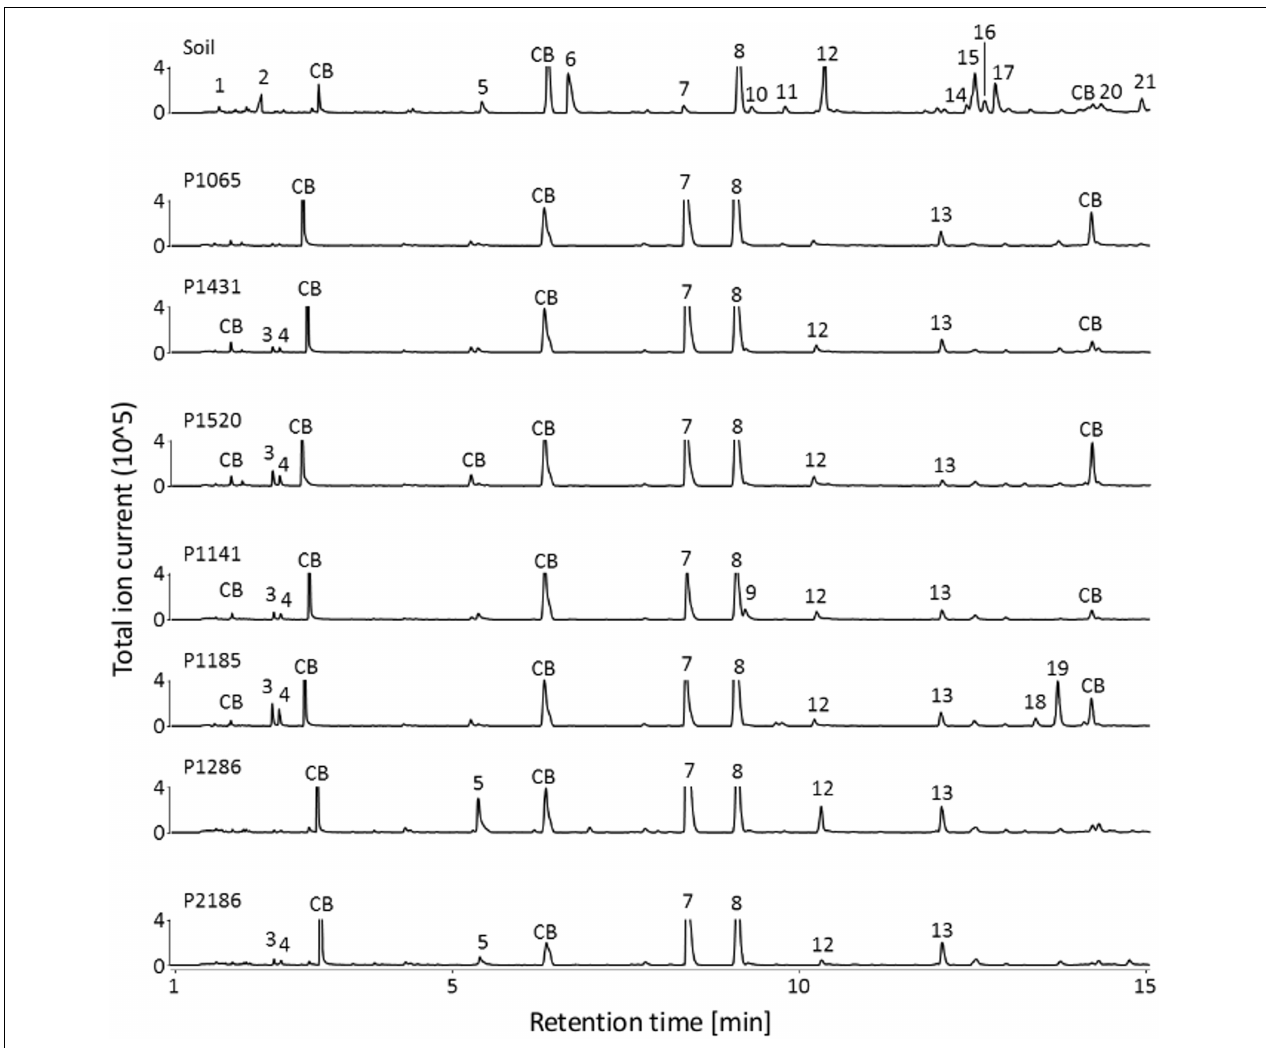
FIGURE 4 | VOCs detected in non-inoculated and Fusarium -inoculated soil samples. GC/MS chromatograms (TIC) illustrating the volatile profiles of non-inoculated soil samples and of Fusarium inoculated soil samples. Fusarium strains overall decreased the number of VOCs detected in the chromatograms compared to non-inoculated soil. CB: column bleed (siloxane derivatives), 1: unidentified, 2: unidentified, 3: 3-methylbutanal, 4: 2-methylbutanal, 5: hexanal, 6: 3-furancarbaldehyde, 7: 4-heptanone ∗ , 8: styrene, 9: 4-heptanol, 10: 2-heptanone, 11: heptanal, 12: methyl-(Z)-N-hydroxybenzenecarboximidate, 13: 7-ethyl-4-nonanone, 14: 2-ethylhexanal, 15: benzaldehyde ∗ , 16: unidentified, 17: 5-methyl-2-furancarboxaldehyde ∗ , 18: unidentified, 19: 1-octen-3-ol, 20: unidentified, 21: octanal ∗ . ∗ Fully identified compounds (based on authentic standard, Kovats-retention indices, mass fragmentation), all other compounds were tentatively identified based on Kovats-retention indices and mass